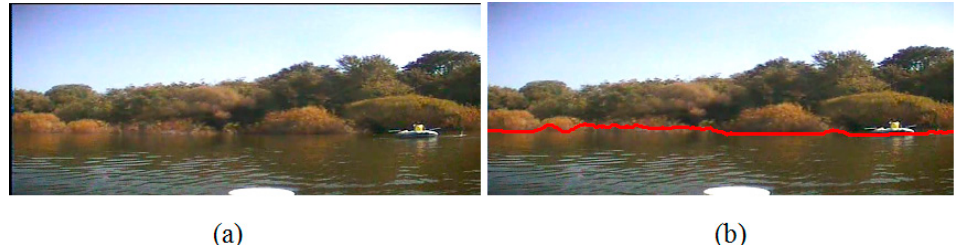
Figure 20. Waterline detection of a close bank with serious shade. ( a ) The image before our detection; ( b ) The image after our detection.